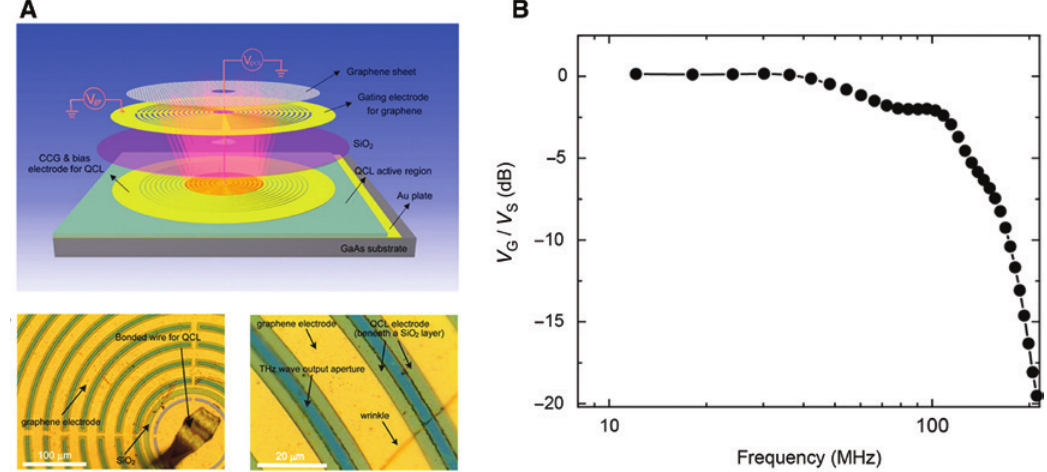
Figure 6: (A) Schematic of the graphene modulator integrated with quantum cascade lasers and optical pictures of the real device. The inner central rings are connected to the top surface of the QCL for biasing the device, while the outer ones contacting the graphene are used for modulating the emission. (B) Frequency response of the graphene modulator, where V voltage on the graphene electrode and that applied to the graphene sheet, respectively. Reprinted and adapted with permission from Liang et al.